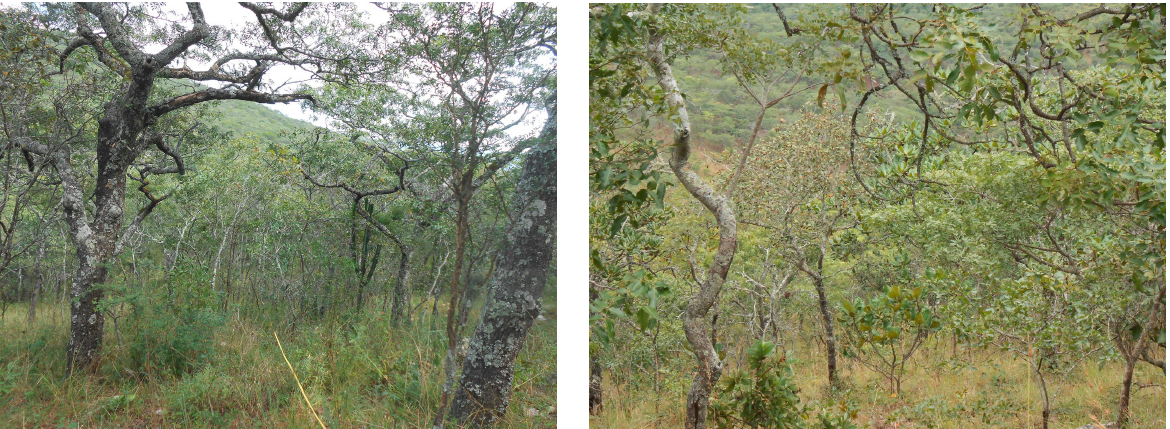
Figure 1. Typical landscapes of a (comparatively) undisturbed dry miombo woodland. Photo source: Rose Pritchard.